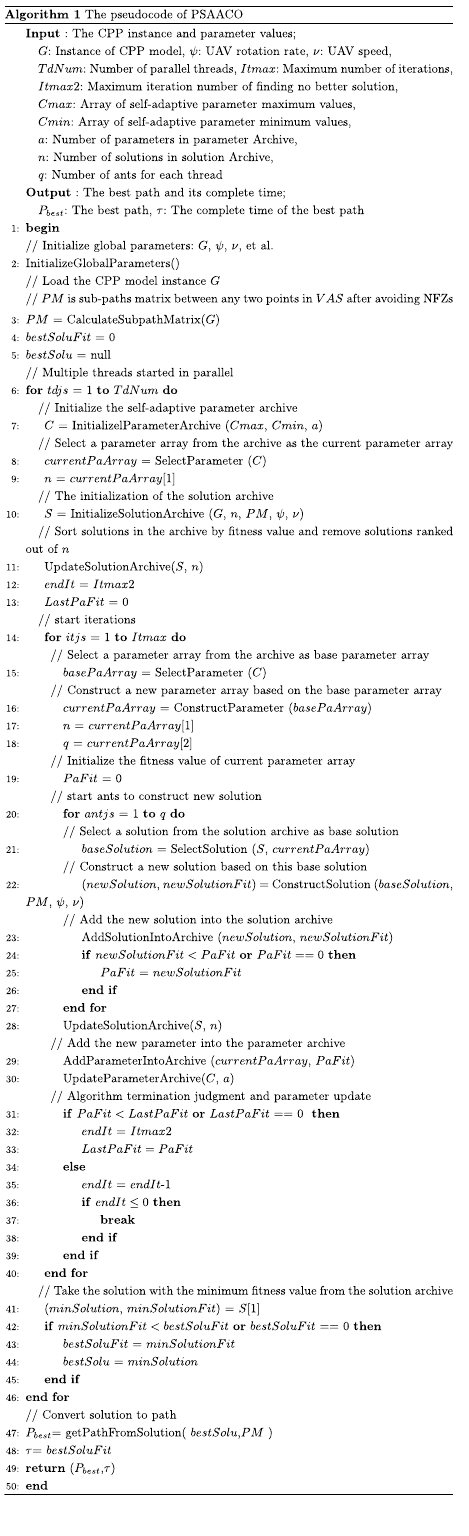
Calculate the Sub‑path Matrix after Avoiding NFZs